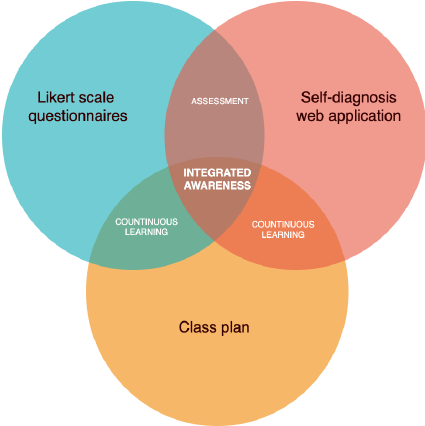
Figure 1. Overall integrated methodology for a cyberawareness in schools.